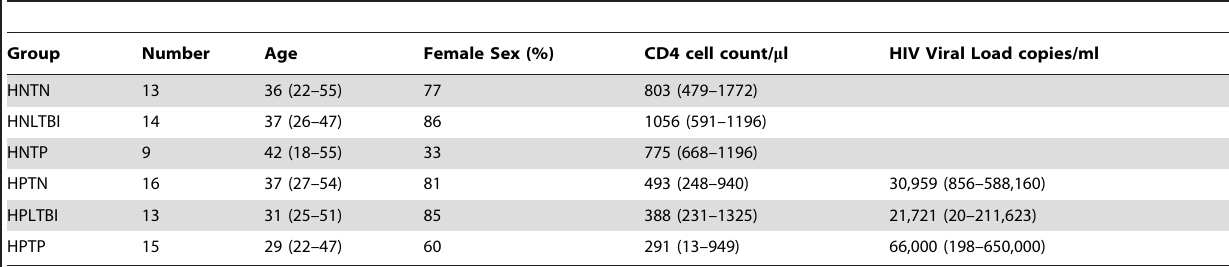
Table 1. Clinical and demographic characteristics of the individuals whose samples were used to assess the frequency and phenotype of the CD161 ++ CD8 + T cell